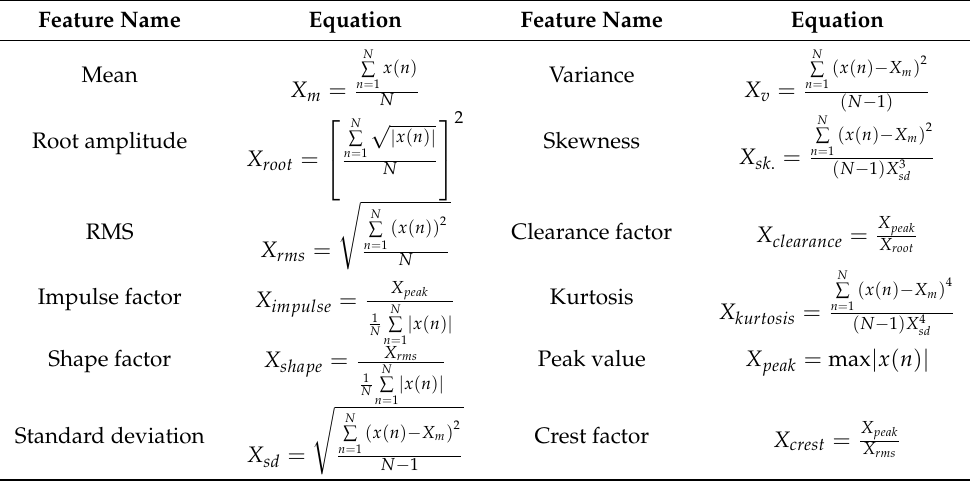
Table 1. Time domain SF’s extracted from the FSFB. The x ( n ) is FSFB in the time domain, N is the sample data points.